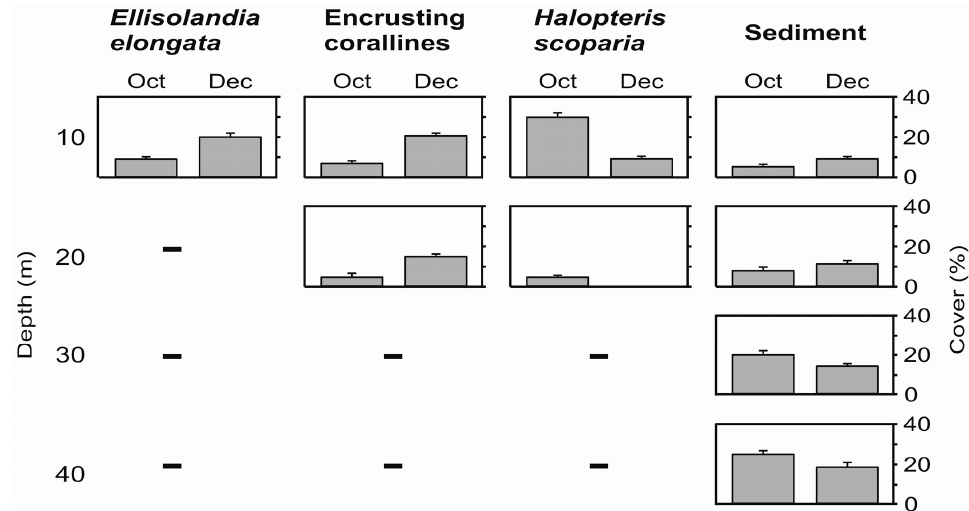
Figure 8. Percent cover (+se) of the species or abiotic components, indicating the effects of the storm and identified by the SIMPER analysis (see Table 3), before (Oct = October) and after (Dec = December) the storm occurrence at four different depths (10 m, 20 m, 30 m, and 40 m).